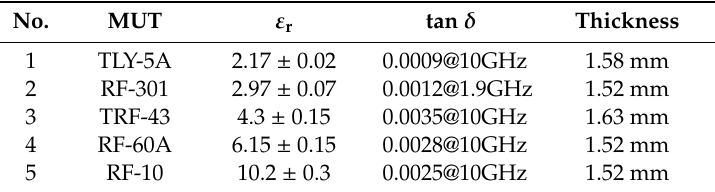
Figure 10. Experiment setups: ( a ) Unloaded; ( b ) loaded. Table 2. Relative permittivity, loss tangent, and thickness of the five MUTs.